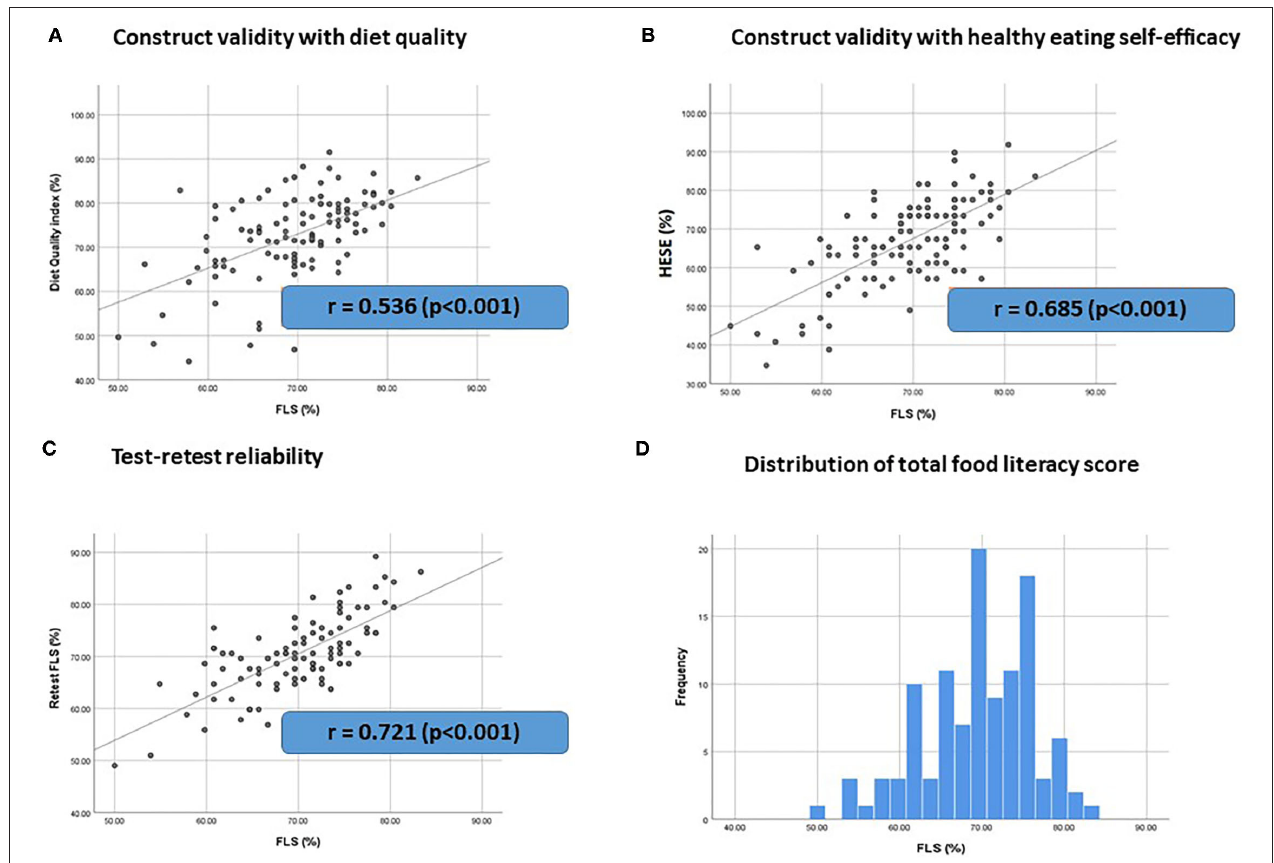
FIGURE 2 | FLS Validity and reliability. ( n = 114) (A,B) Construct validity of the FLS against dietary variables (A) diet quality and (B) healthy eating self-efficacy (HESE) that are expected to be related with food literacy. r = Pearson correlation coefficient. (C) Test-retest reliability of the FLS. r = interclass correlation coefficient. (D) Distribution of total food literacy score.